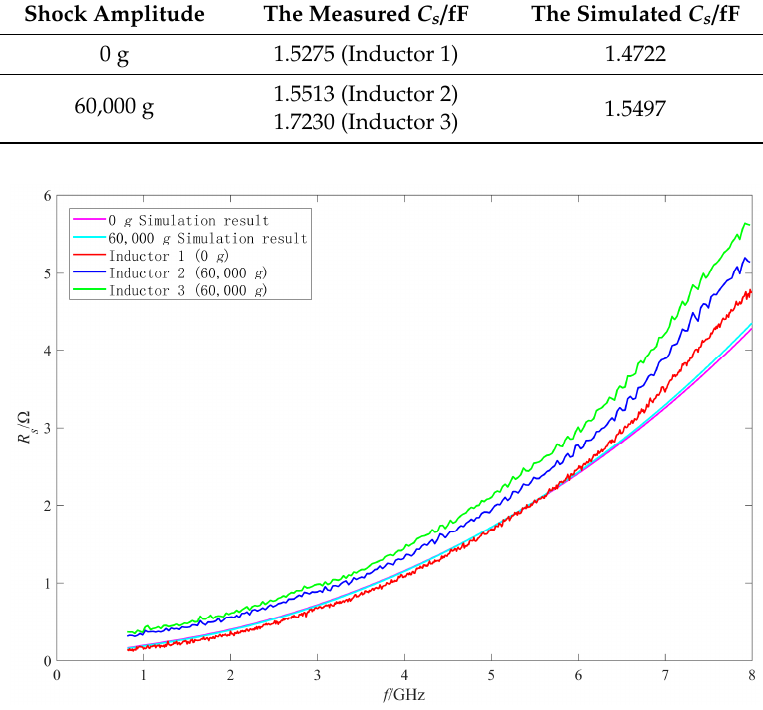
Figure 19. The measured and simulated 𝑅 (cid:3046) of the intact inductors before and after shock test.